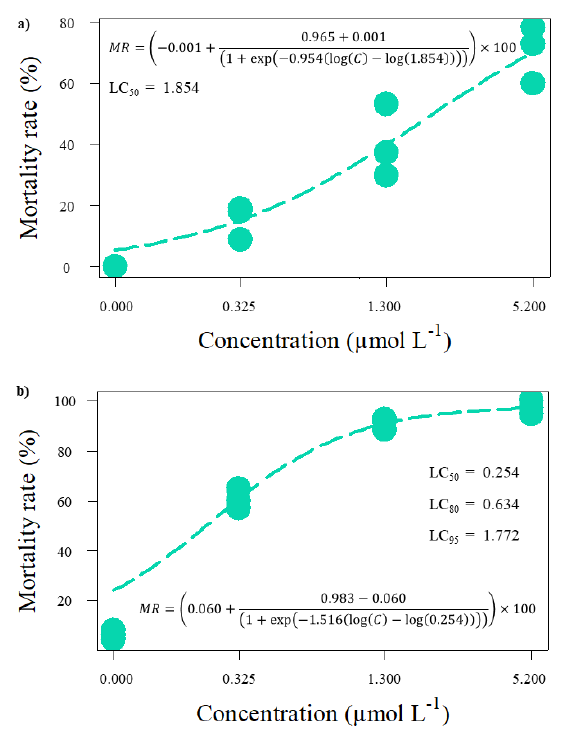
Figure 1. Response-curve of Mortality rate (%) as a function 2-Phenylethynyl-Butyltellurium (PEBT) Concentration (µmol L -1 ) via log-logistic nonlinear model, in 24h (a) and 48h (b). MR Mortality Rate. C Concentration of PEBT. R² Coefficient of determination. LC 50% Lethal Concentration. LC 80% Lethal 50 80 Concentration. LC 95% Lethal 95